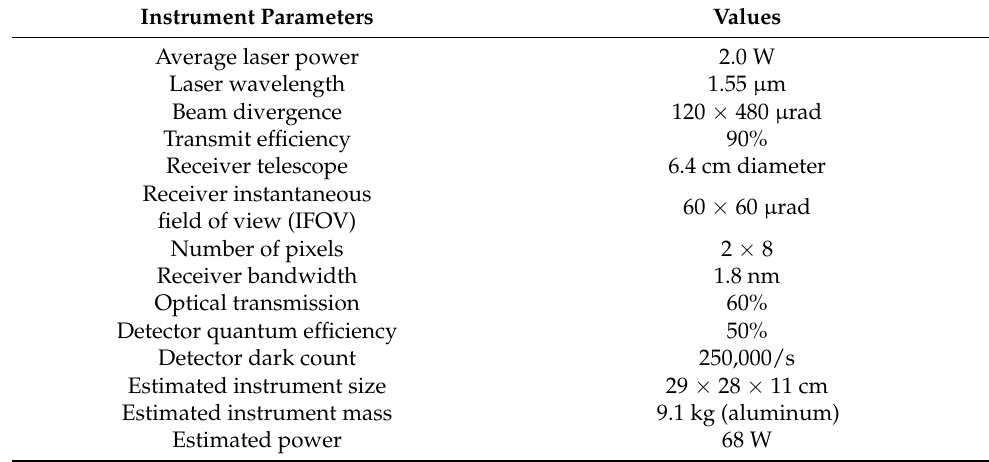
Figure 2. Conceptual design of the SALi instrument which combines a CubeSat laser communication terminal [50] with a HgCdTe APD detector-cooler assembly [29,52]. Table 2. SALi instrument parameter